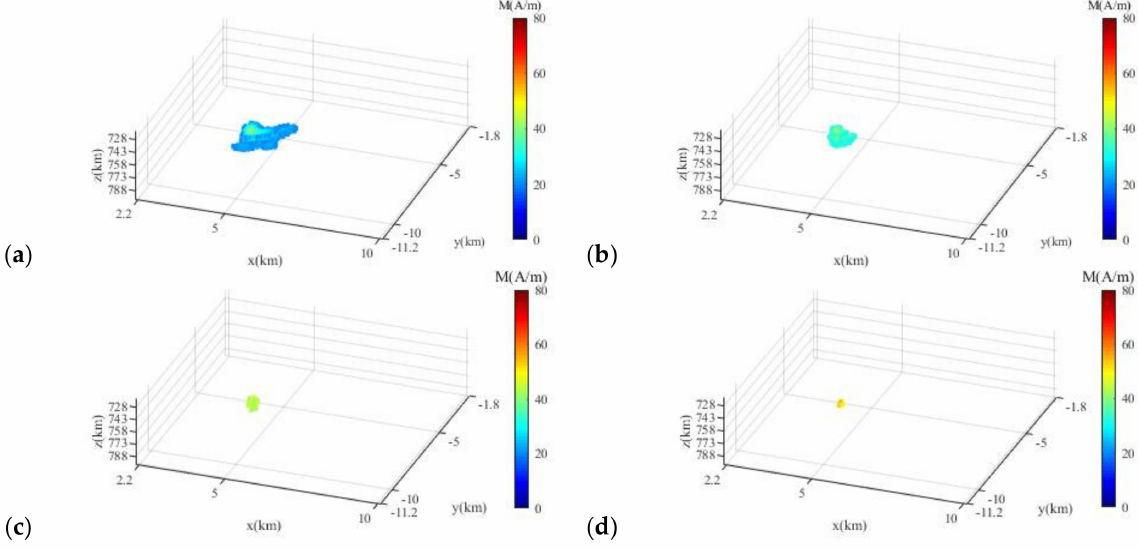
Figure 16. Inversion results of a magnetite-caused anomaly in Dazhang Pluton subregion: ( a ) magnetization less than 20 A/m removed; ( b ) magnetization less than 30 A/m removed; ( c ) magnetization less than 40 A/m removed; ( d ) magnetization less than 50 A/m